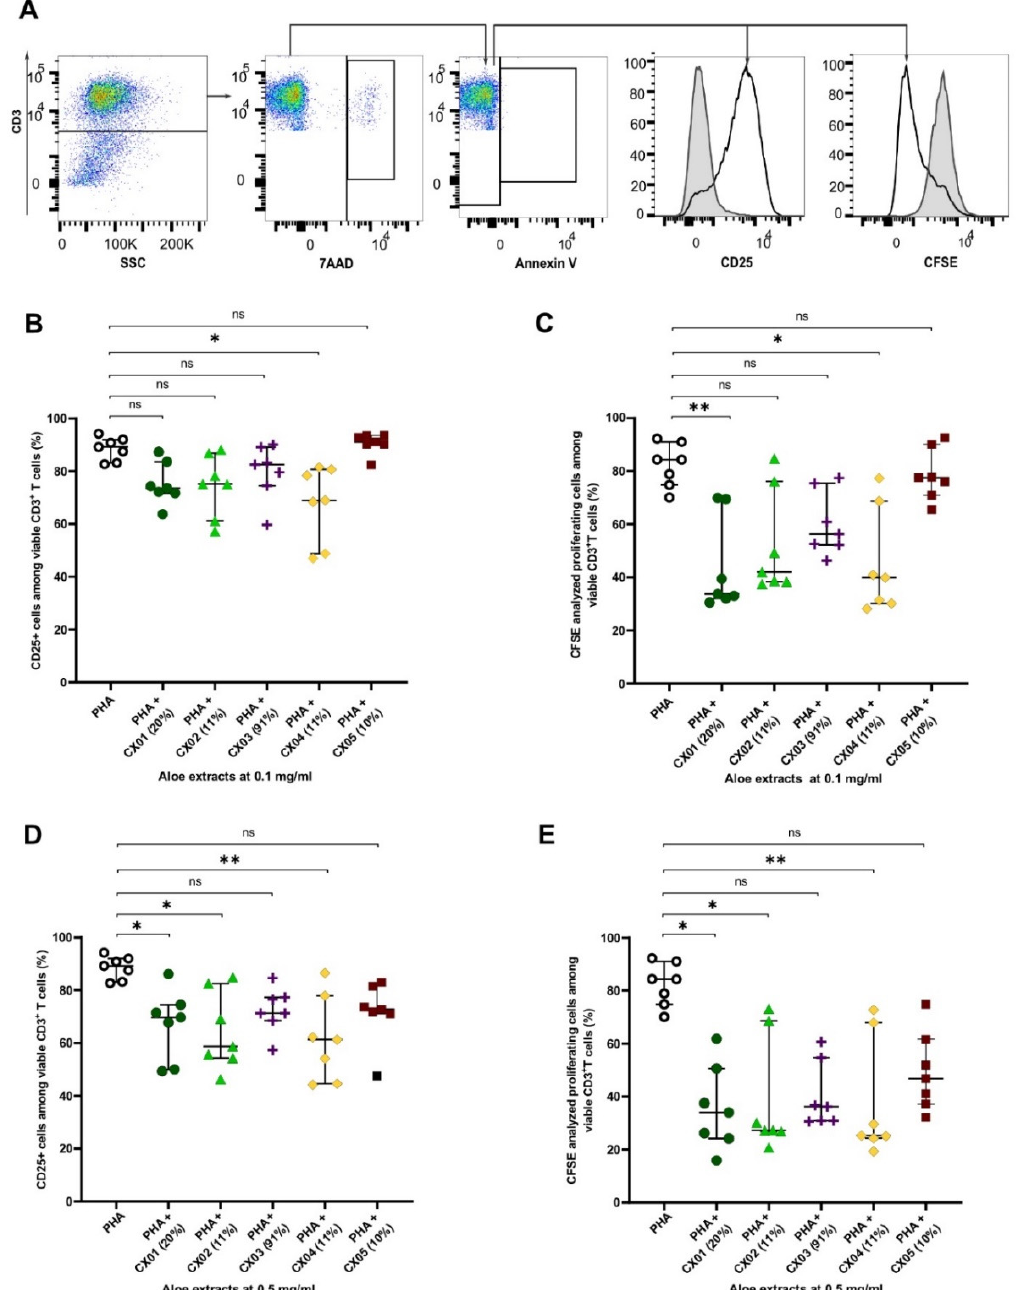
Figure 1. Effect of Aloe extracts on activation and proliferation of polyclonally stimulated T cells. Total PBMCs from seven donors were stimulated for 72 h with PHA in the presence or absence of Aloe extracts with varying acemannan content (% dry weight shown within brackets) at two doses (0.1 and 0.5 mg/mL). Extract CX05 is of high molecular weight. ( A ) Gating strategy for T cells identified as CD3 + cells. The frequency of activated T cells and proliferating T cells was defined as CD25 + cells and CFSE analyzed proliferating cells among viable 7AAD − Annexin V − CD3 + T cells, respectively. Histograms show PHA stimulated (colorless) and unstimulated (gray solid, negative control) T cells with frequency of activated T cells (left) and proliferating T cells (right). ( B , D ) Activated T cells identified by the frequency of CD25 + cells among viable CD3 + T cells. ( C , E ) Proliferating cells among live CD3 + T cells measured by 5,6-carboxyfluorescein diactate ester (CFSE) emitting cells by flow cytometry. Asterisks represent significant p values: * <0.05; ** <0.01. ns: not